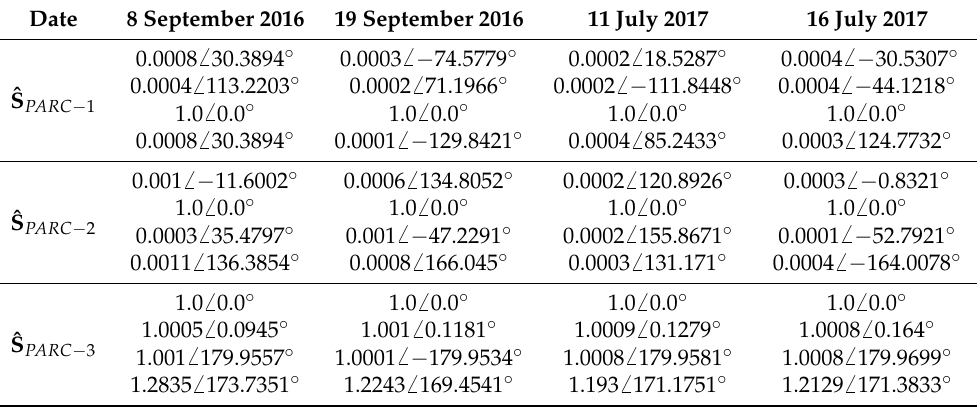
Table 5. The correction results by the polarimetric distortion matrices from Freeman’s